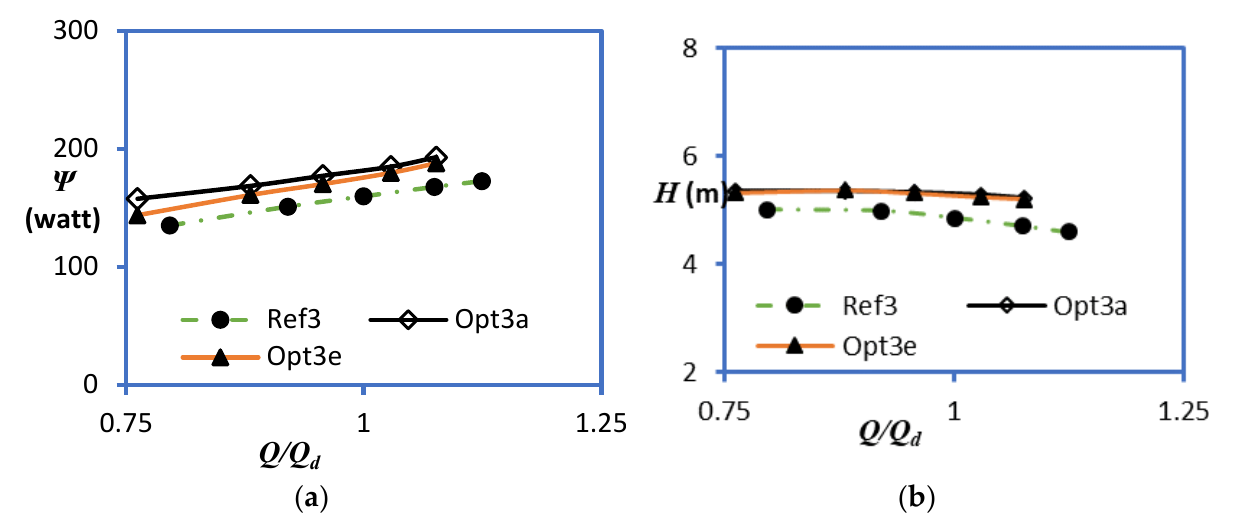
Figure 17. Pump performance comparison for oil C2: ( a ) Ψ versus Q/Qd and ( b ) H versus Q/Qd.